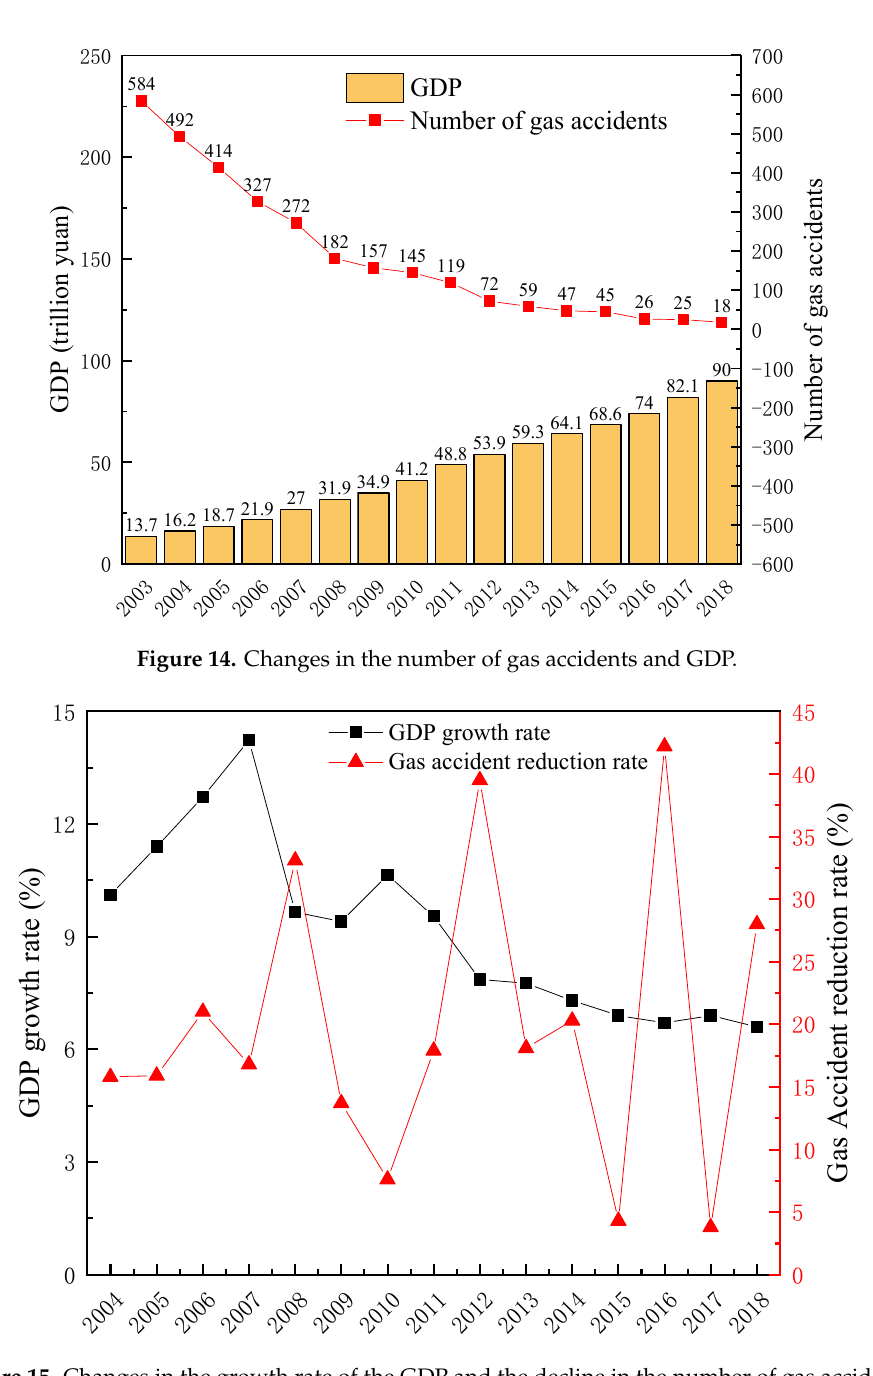
was significantly curbed and decreased significantly. However, from 2008 to 2010, the decline rate of the number of gas accidents elicited a large drop, from 33.1% to 7.6%, indicating that the number declined during this period and that the rate of decline slowed. Nevertheless, these trends are not